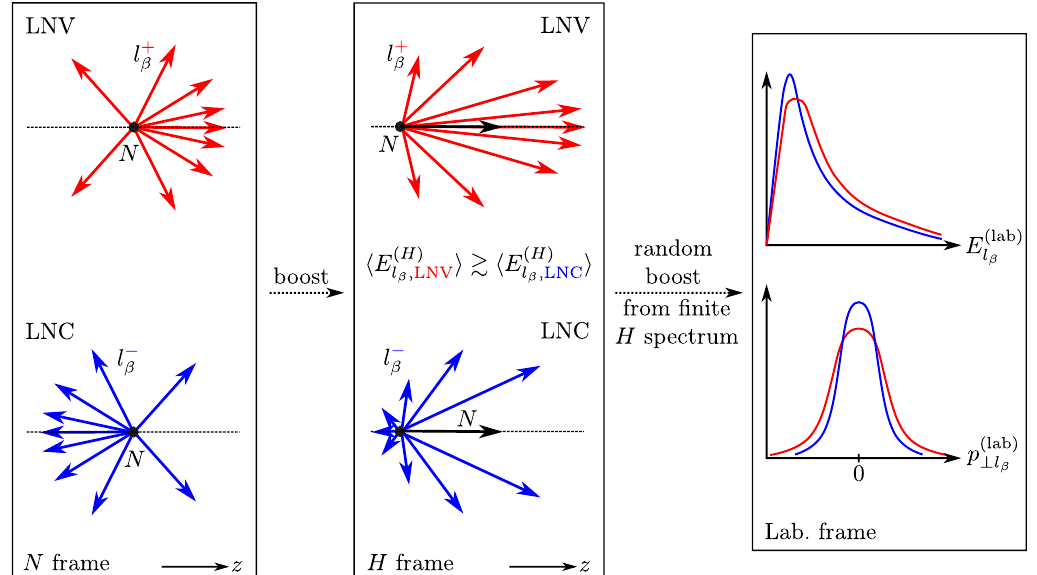
Figure 6. This sketch shows how the di(cid:11)erent distributions of l vs. LNV processes a(cid:11)ect the corresponding distributions in the rest frame of the heavy hadron H and in the laboratory frame. The various momenta shown for l the decay. In the H frame, LNV processes typically result in larger momenta for l In the laboratory frame, this e(cid:11)ect partly survives the averaging over the heavy hadron spectrum and manifests itself as a broadening of the distribution of the secondary lepton momentum p